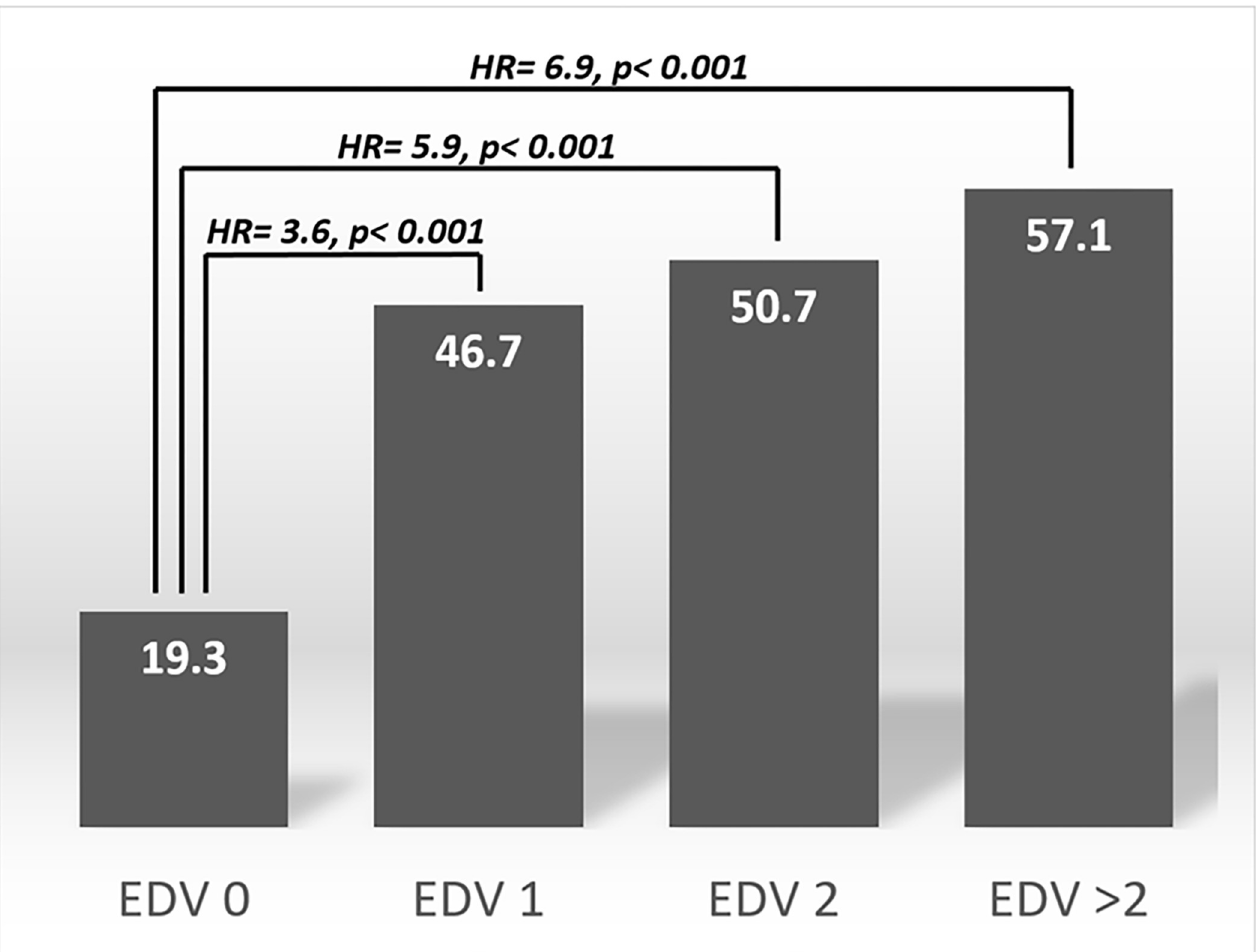
Fig 2. Percentage frequency of conversion according to emergency department visits (EDV). Multiple logistic regression analysis was adopted for investigating the contribution of EDV to the predementia participants’ conversion to dementia. Hazard ratios (HR) were adjusted for age, sex, education, cognition (CASI), activities of daily living (HAIADL), neuropsychiatric symptoms (NPI), cerebrovascular disease, parkinsonism, diabetes, hypertension, dyslipidemia, and coronary artery disease. Compared to EDV 0, HR were 3.6, 5.9, and 6.9 in EDV 1, EDV 2, and EDV > 2, respectively.